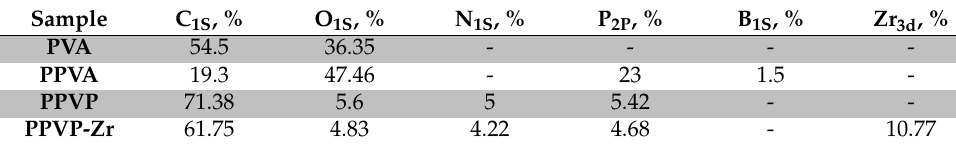
Table 2. The pore volume, surface area (S BET ) and pore size of PVA, PPVA and PPVP.